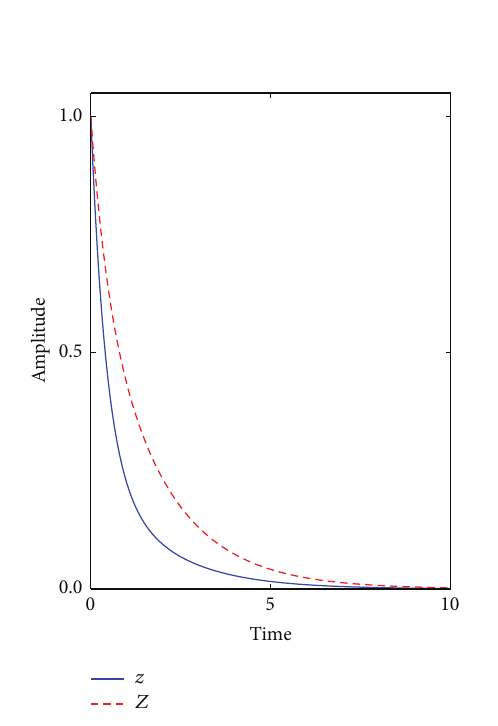
Figure 5: Time evolution of dynamic variables 𝑧 and 𝑍 for 𝑐 = 0.8